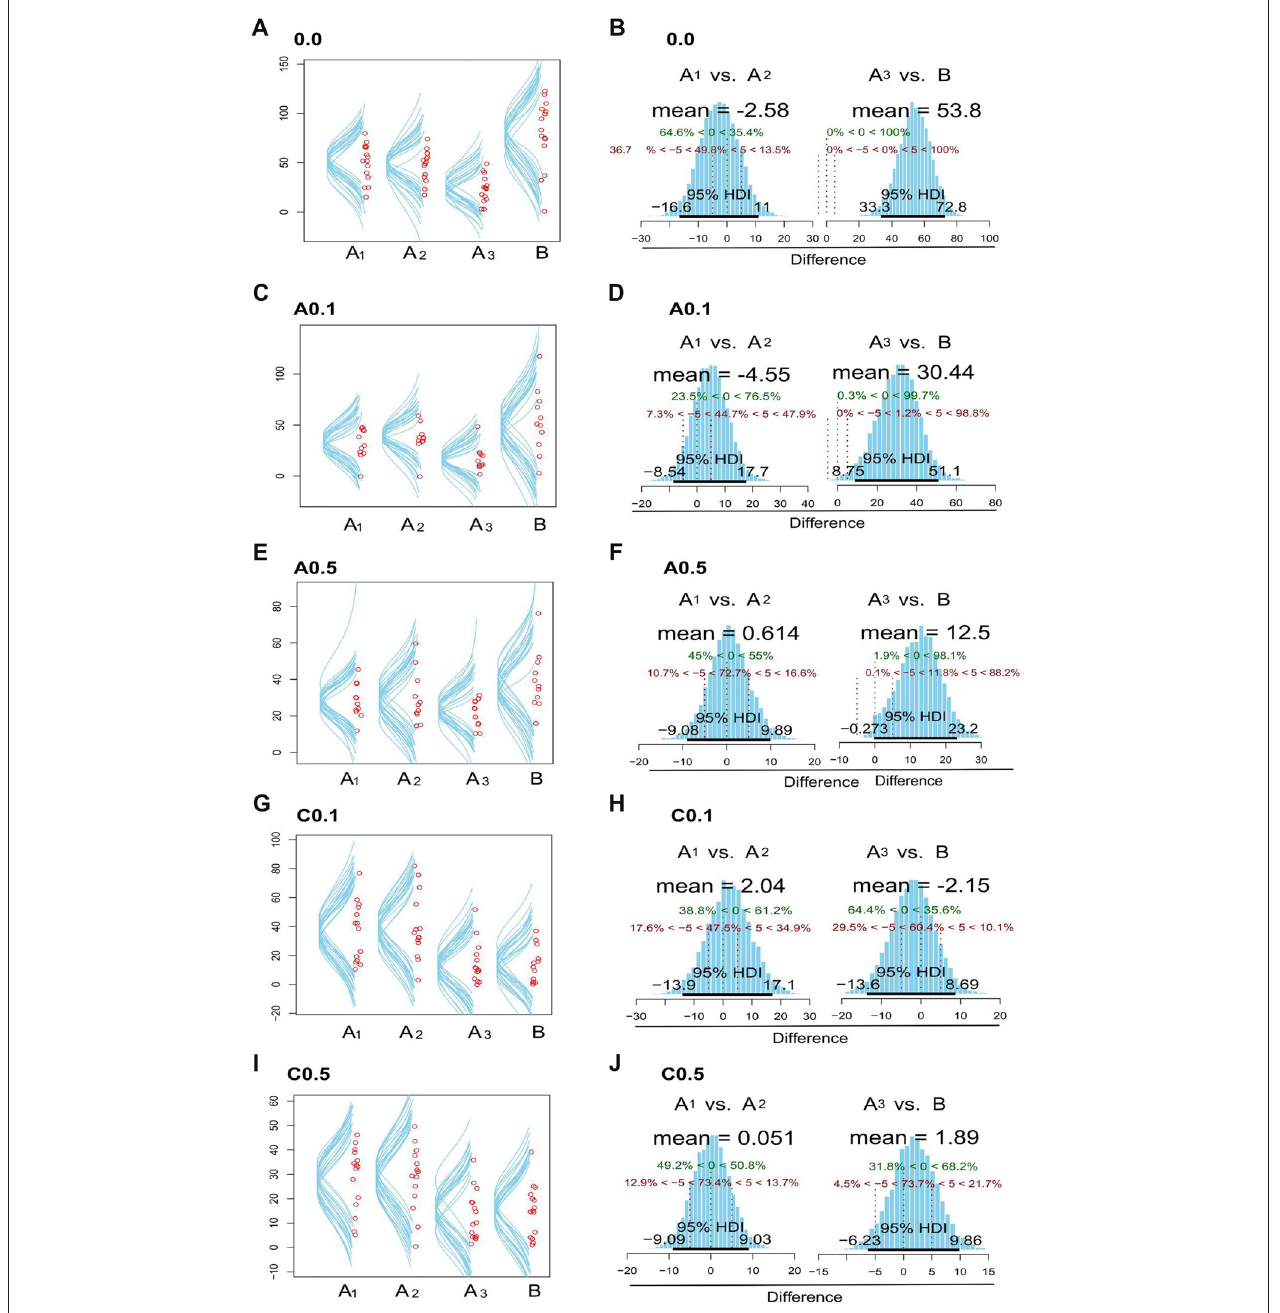
FIGURE 2 | Plots zebrafish exploration of objects A 1, A 2, A 3 and B. Fish were observed for 15 min and the time spent near the objects were considered as exploration. The left side column (A,C,E,G,I) shows the dispersion of median values for exploration time in each object, both in memorization and in discrimination phases, for the 0.0, A0.1, A0.5, C0.1 and C0.5 groups. The right column (B,D,F,H,J) exhibits posterior distribution of the Bayesian analysis: comparison between the exploration time of objects A 1 vs. A 2 and A 3 vs. B for the five groups tested. Green dashed lines (central dashed line) indicate the comparison value = 0 and red dashed lines (lateral dashed lines) indicate the Region of Practical Equivalence (ROPE) ± 5. 95% highest density interval (HDI) is marked by the black bar on the floor of the distribution. For further details and statistical analyses, see the “Results” section.